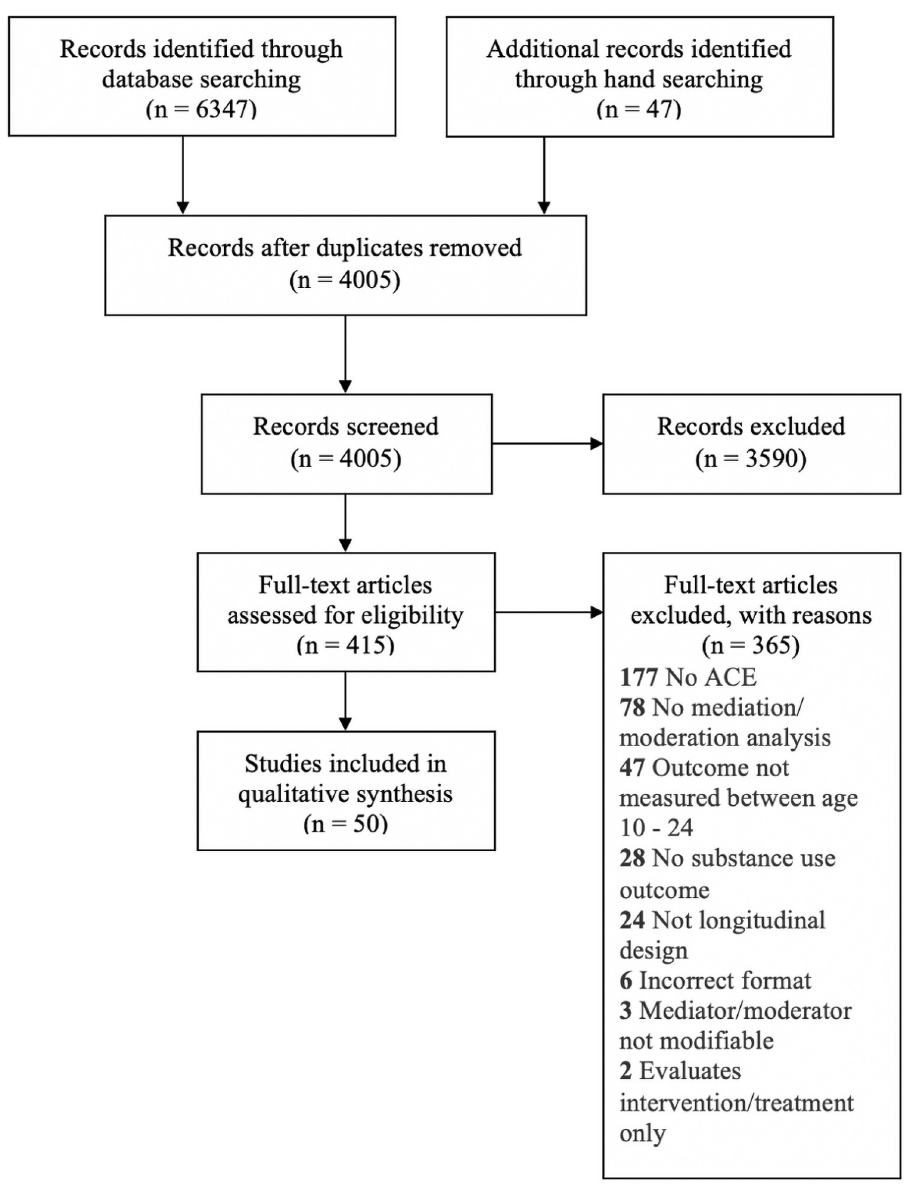
Fig 2. Prisma 2009 flow diagram. Study screening flow chart for studies identified in the systematic review. Titles and abstracts were screened for 4005 studies, resulting in 415 studies for full-text review. Of these, 50 studies were included in the current qualitative